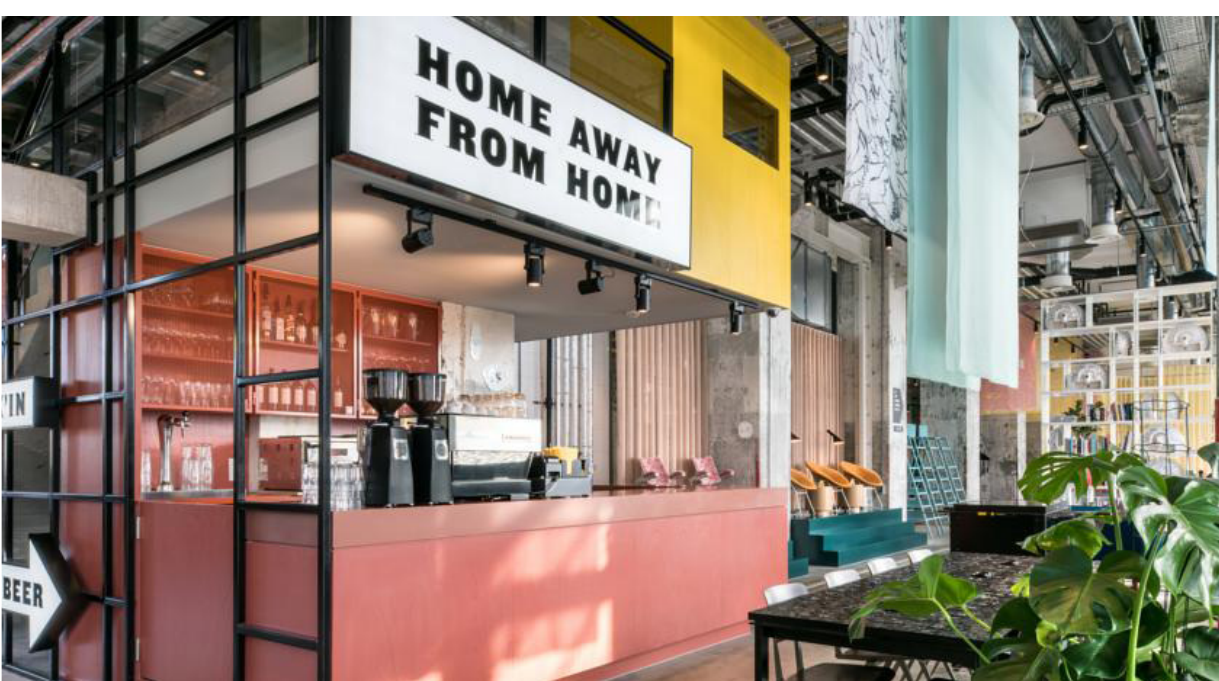
Figure 5. The Student Hotel café in Maastricht. Source: The Student Hotel (n.d.). as shelter and on floor area is replaced in the contempo‐ rary discourse by a narrative of experiential features and immaterial